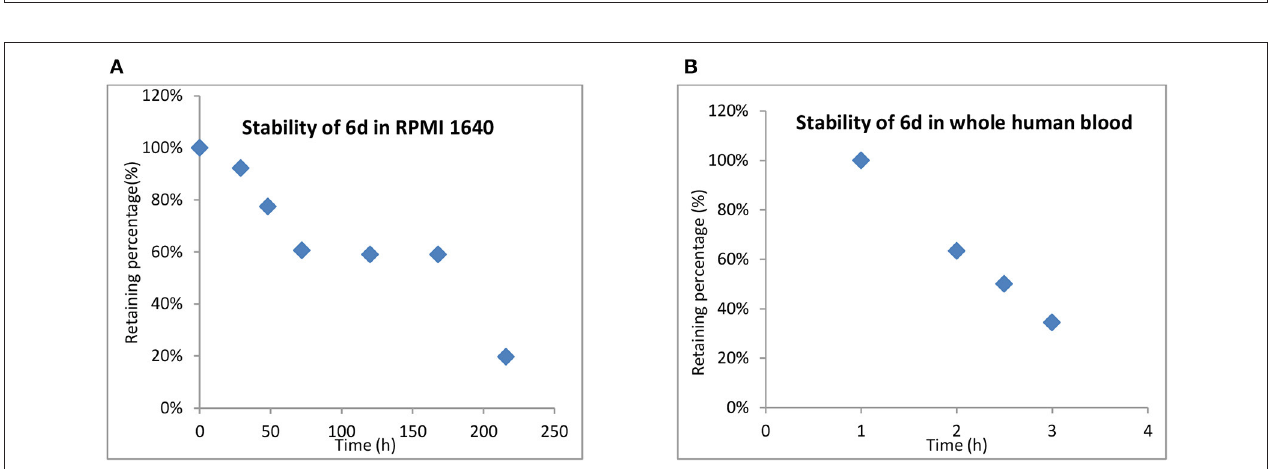
FIGURE 6 | Stability of 6d in RPMI 1640 (A) and whole human blood (B)